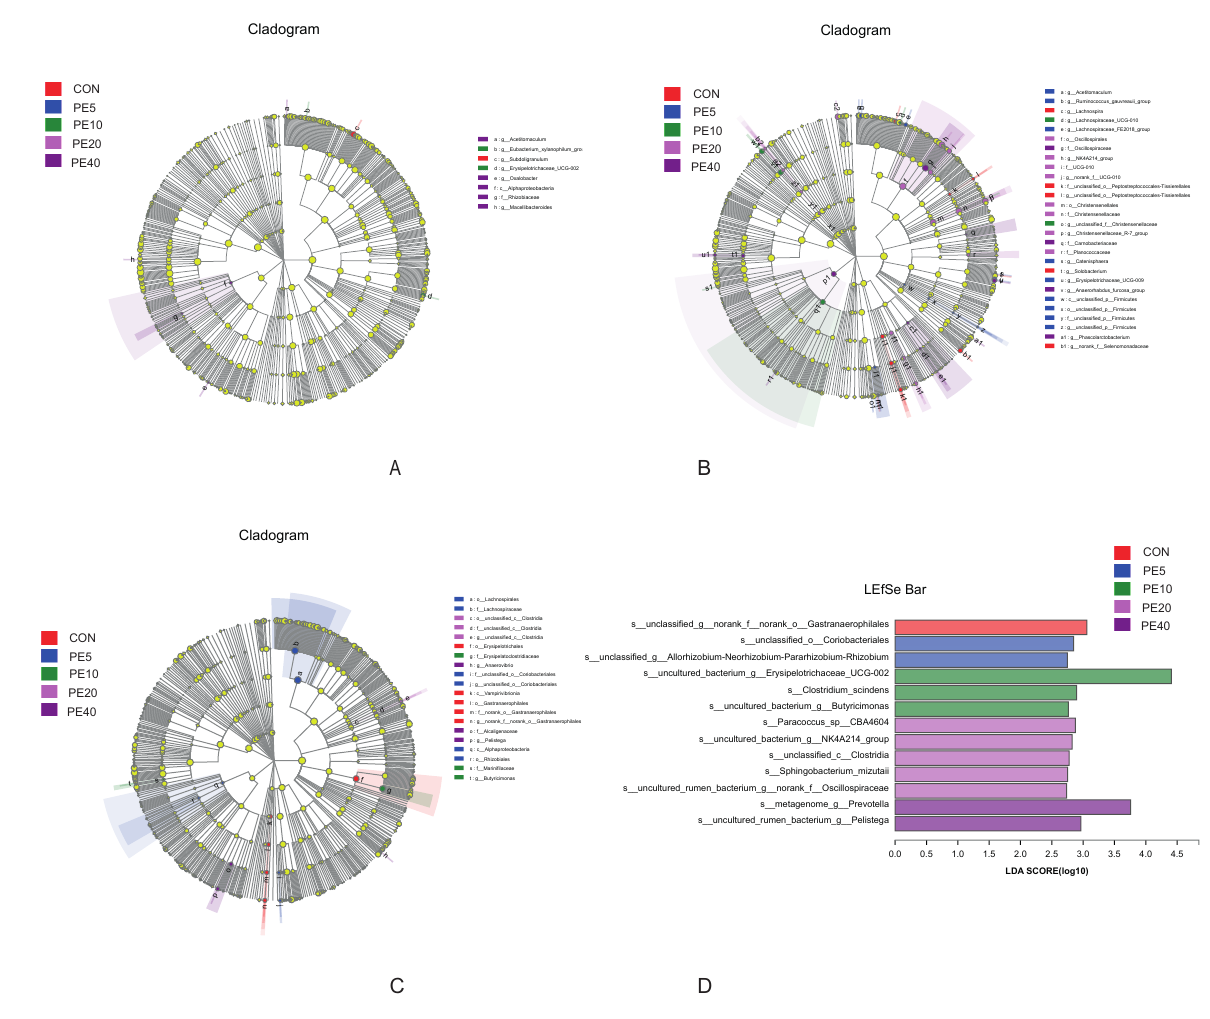
Figure 5. LEfSe analysis (LDA, threshold of 2) of rumen bacterial taxa that were significantly enriched among the groups of calves supplemented with different levels of Amla ( Phyllanthus emblica ) whole- fruit powder at ( A ) 14 days of age; ( B ) 42 days of age; ( C , D ) 75 days of age. CON, PE5, PE10, PE20, and PE40 indicate control (0), 5, 10, 20, and 40 g/d/head supplementation of Amla fruit powder,